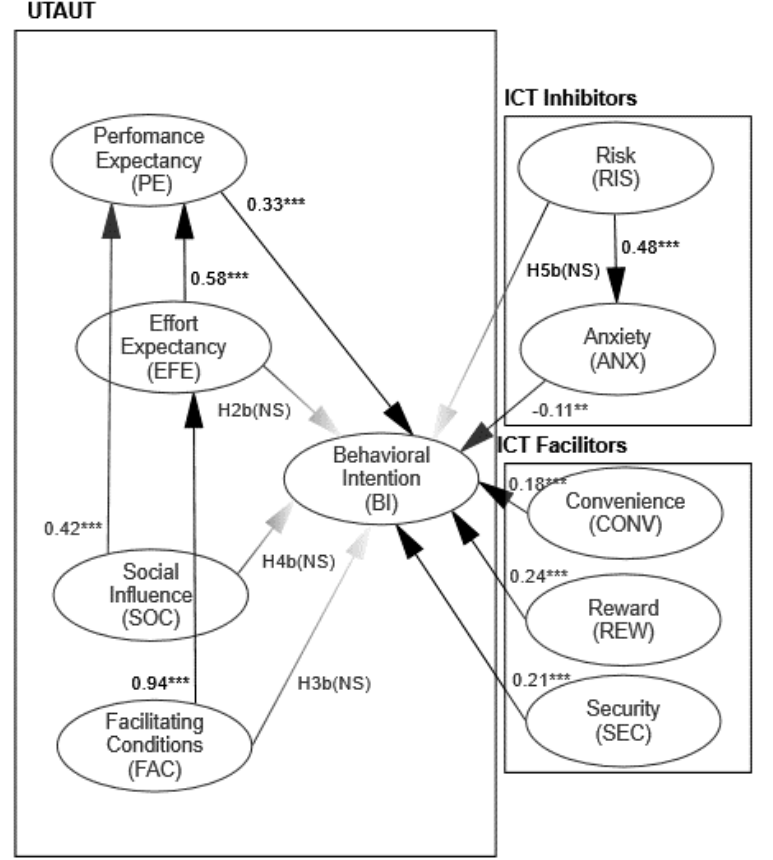
Figure 2. Results of the structural model ** p < 0.01. *** p < 0.001.